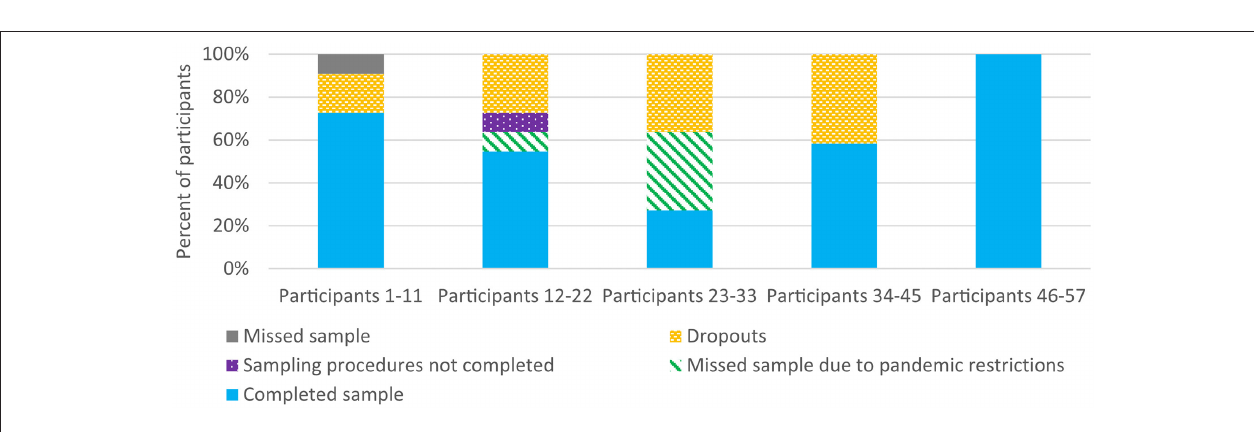
FIGURE 6 | Participation in the third blood sample (primary endpoint), divided into five groups according to the inclusion order in the preparatory